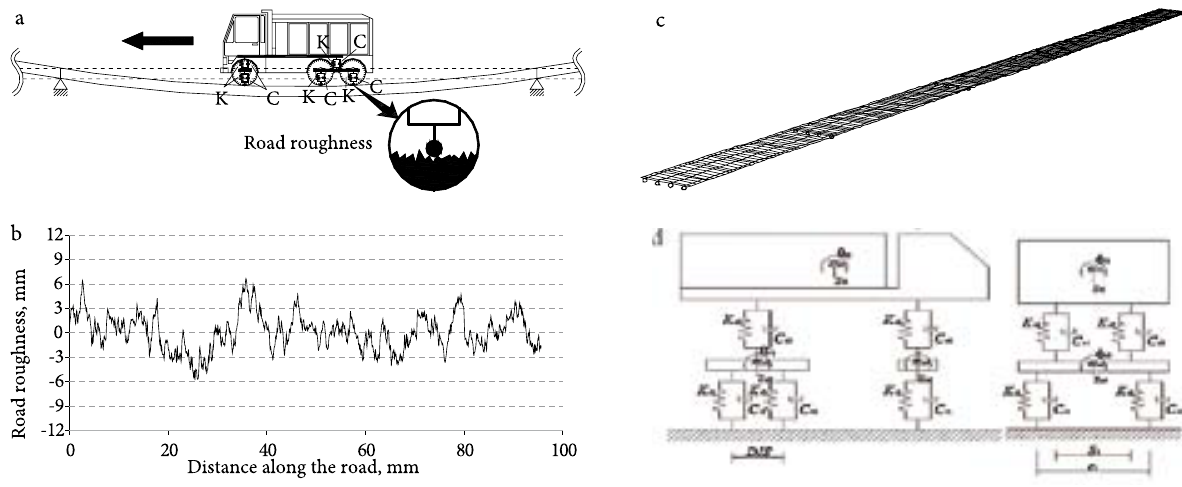
Fig. 12. Analysis model: a – modeling of vehicle–bridge interaction; b – road roughness; c – modeling of test bridge; d – modeling of test